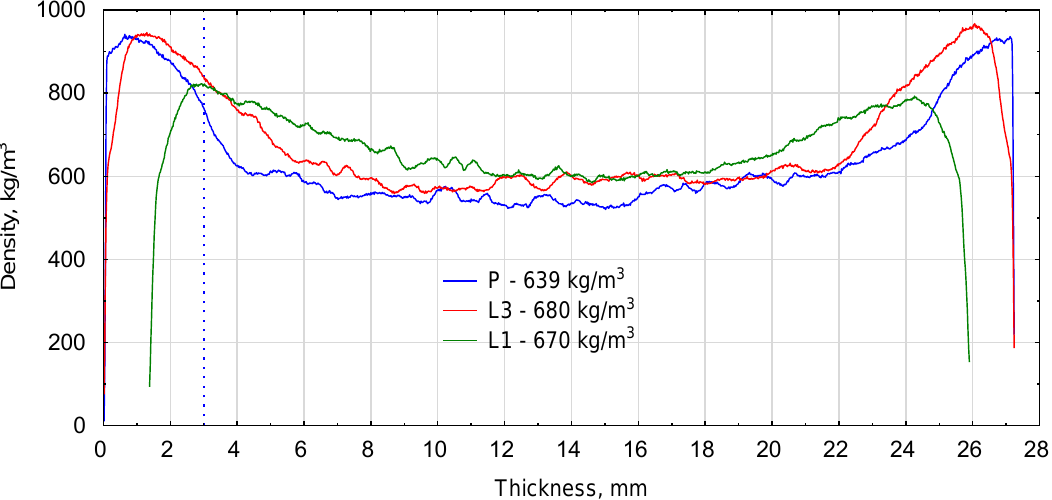
Figure 4. Density profiles: P – industrial board, L1 – one-ply chip-sawdust board, L3 – three-ply board.